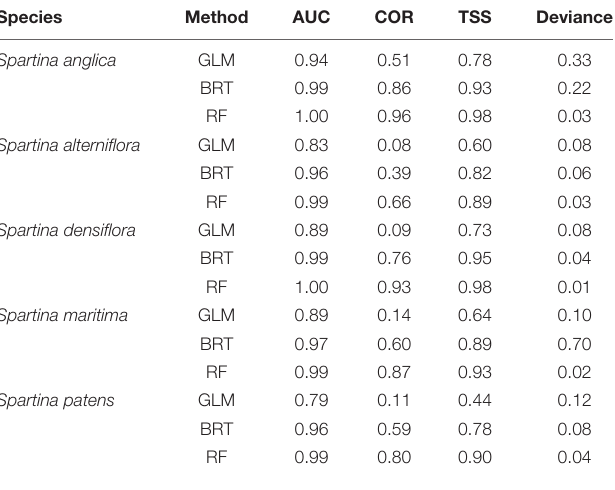
TABLE 1 | Mean performance (per individually modeled species) of computed SDM model methods (GLM, generalized linear model; BRT, boosted regression tree; RF, random forest), using an independent test